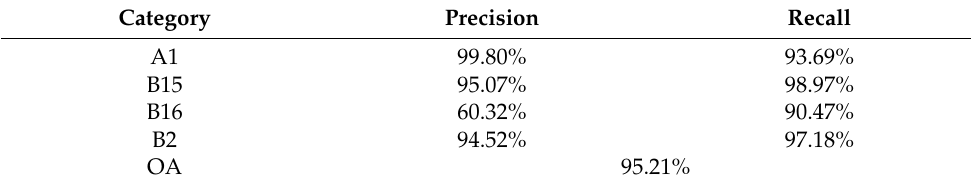
Table 4. Precision and recall of test set